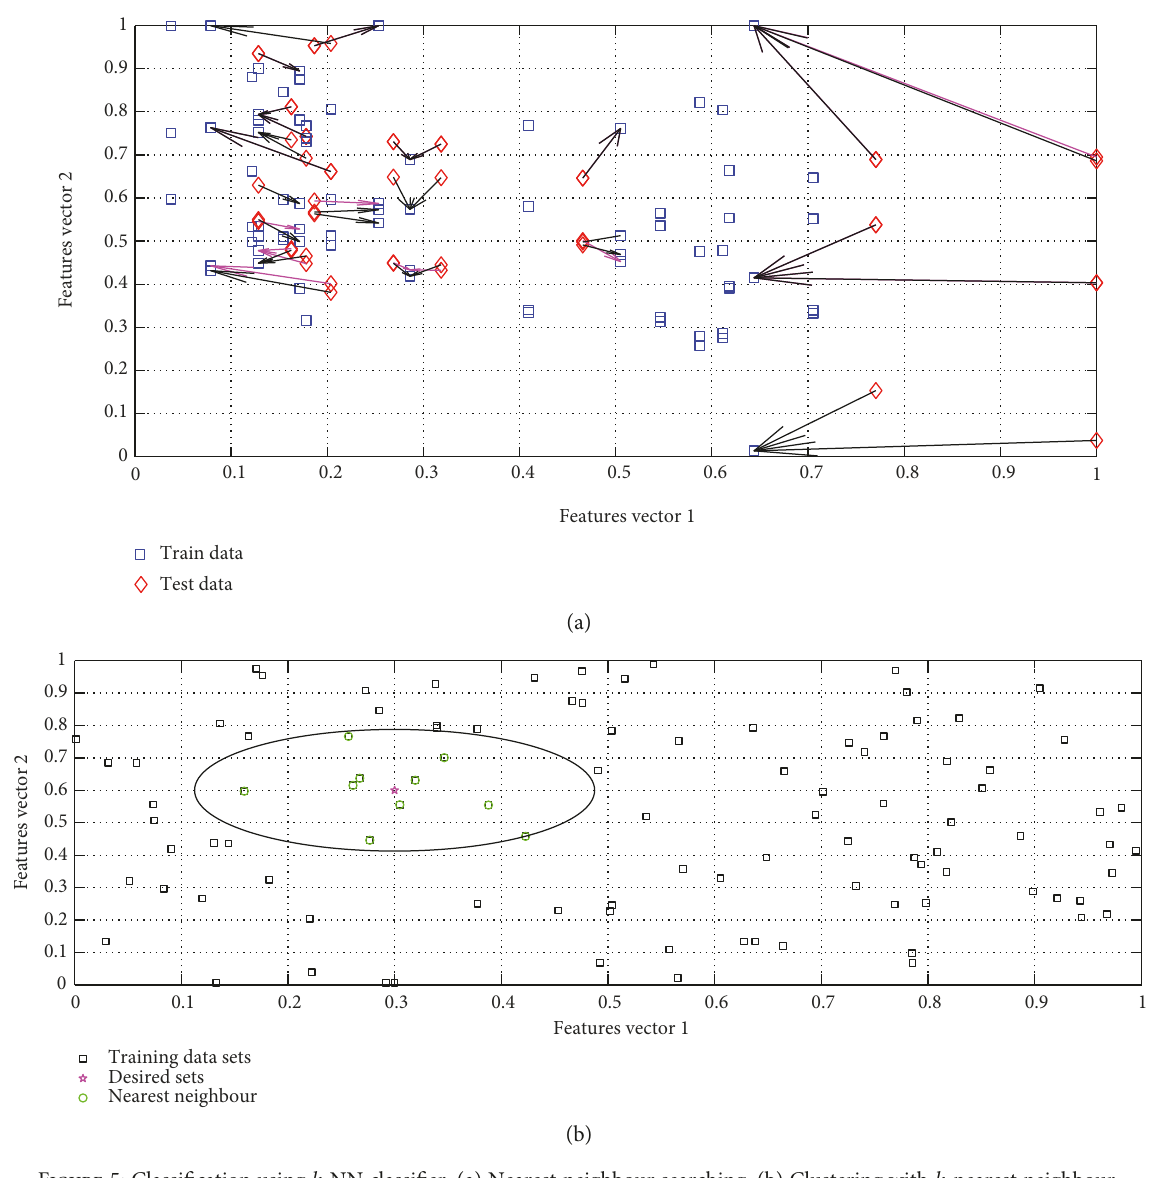
Figure 5: Classi fi cation using k -NN classi fi er. (a) Nearest neighbour searching. (b) Clustering with k -nearest neighbour. Table 2: Percentage of accuracy due to variation of nearest number k and other parameters kept constant. Distance